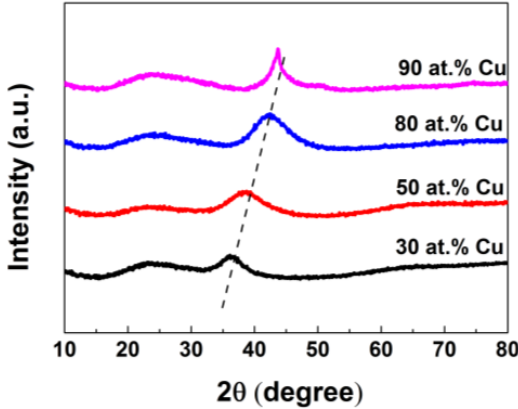
Figure 1. X-ray diffraction patterns of Zr-Cu glassy coatings.